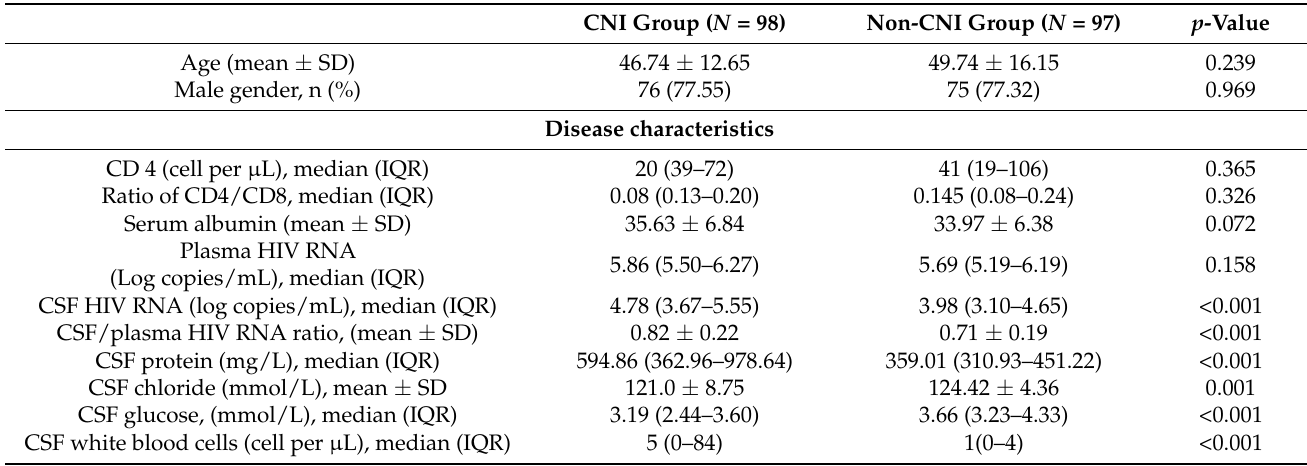
Table 1. Baseline characteristics according to central nervous